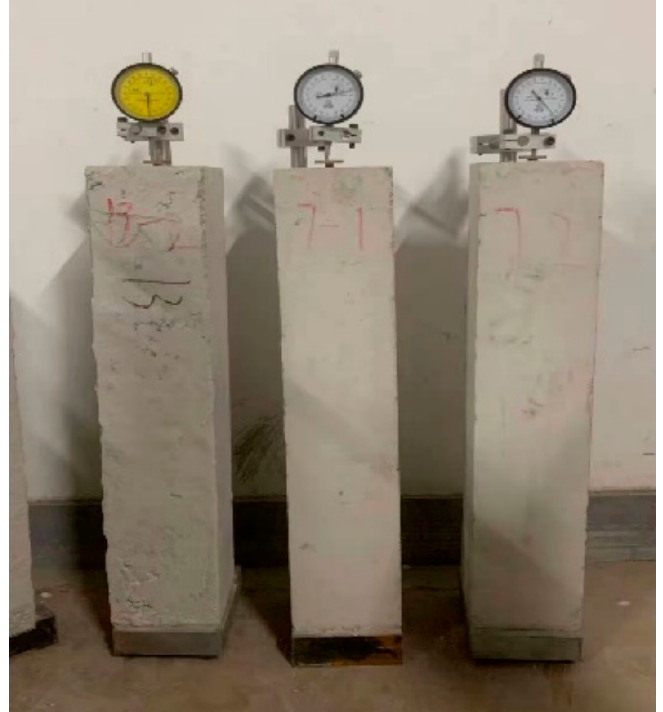
Figure 1. Measurement of the expansion rate of specimen.